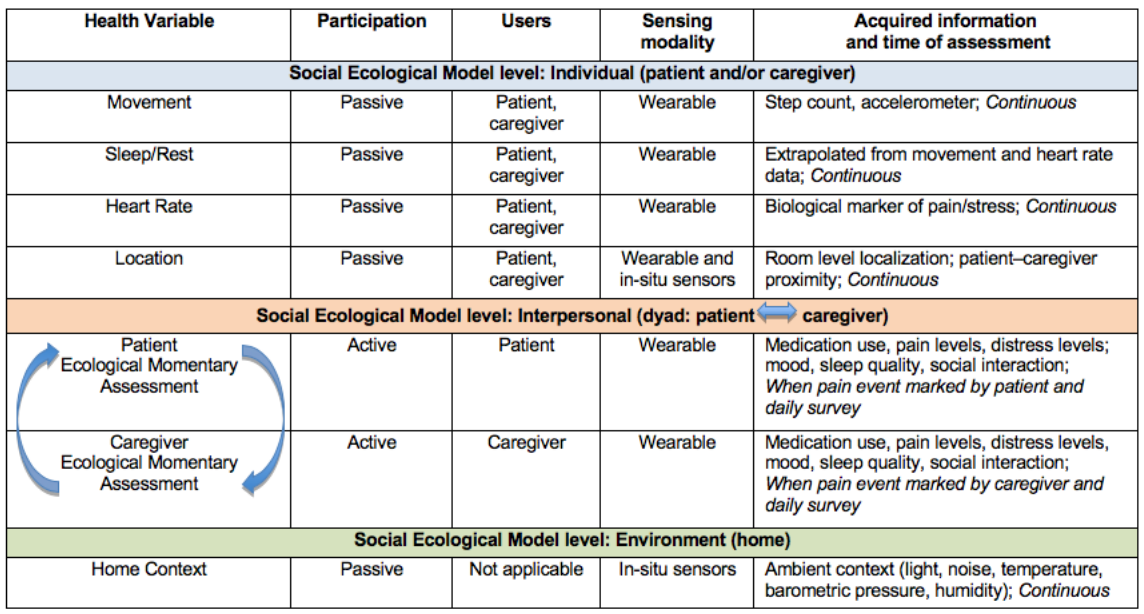
Figure 2. Health variables measured by Behavioral and Environmental Sensing and Intervention for Cancer and related sensing